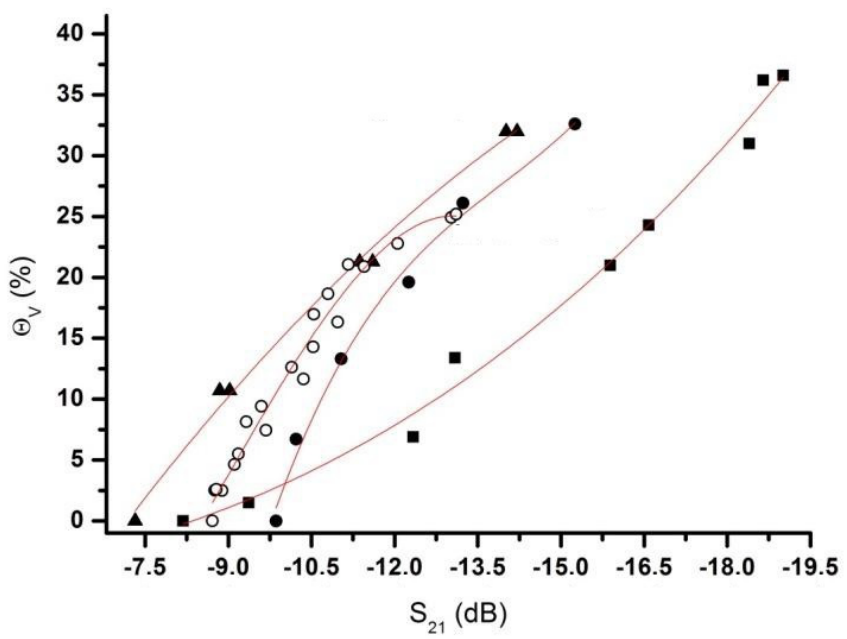
Figure 9. Relationship between the S 21 measured with the developed system and the volumetric soil moisture θ V determined and calculated by the second and third order polynomial equation. The equations are presented in Table 3. The four (04) samples used are Cerrado Soil (squares), Nullerde (dots), Kaktus Soil (open circles) and Glass Beads (triangles). The experiment was carried out at standard laboratory ambient conditions (Temperature (T(°C)) = 25.0 ± 0.5 °C and Relative Humidity (RH(%)) ≅ 30%).